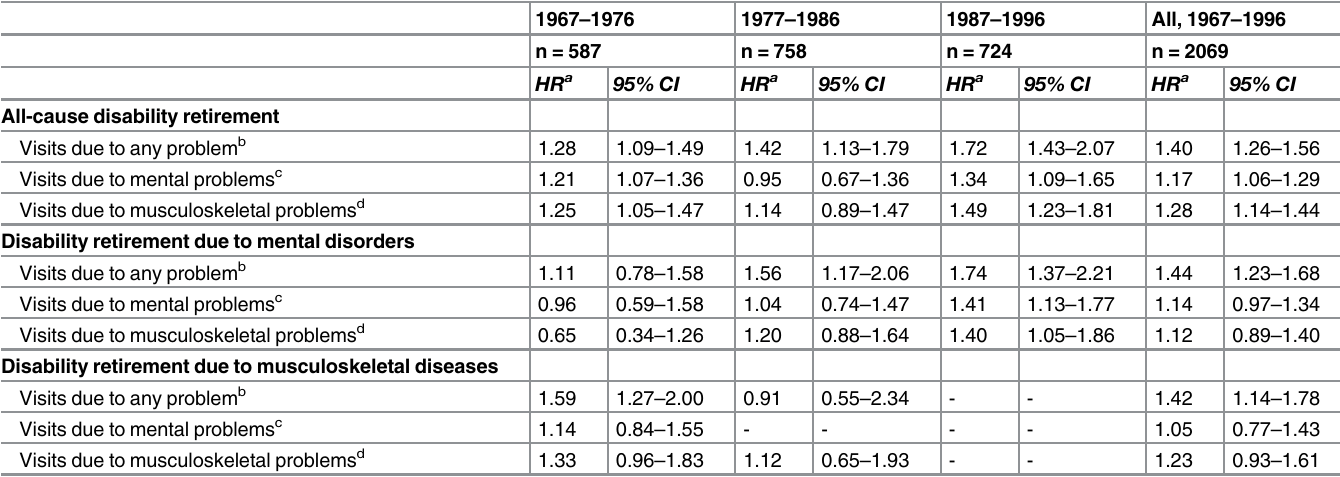
Table 4. Seeking care (visits per service months) during military service and disability retirement by the service time